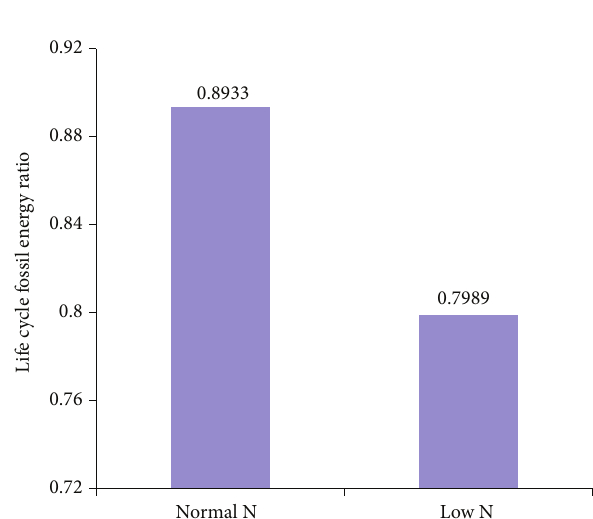
Figure3:Lifecyclefossilenergyratiofortheproductionofbiodiesel from Phaeodactylum tricornutum grown in normal and limited nitrogen supply